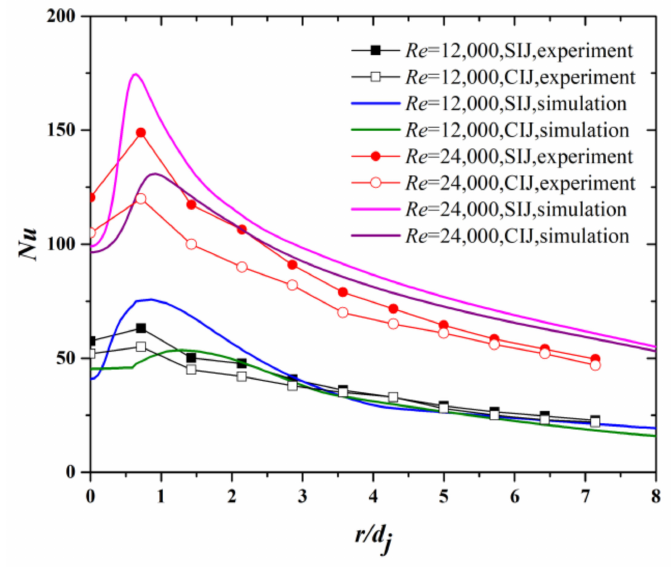
Figure 19. Comparison of Nu values between CIJ and SIJ ( h = 2 d j